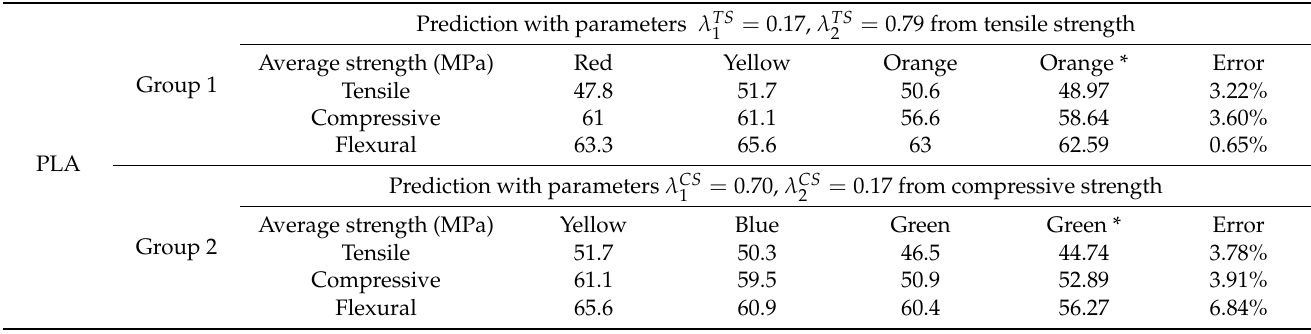
Table 5. Predicated values for mechanical strengths of PLA with two-mixed colors.